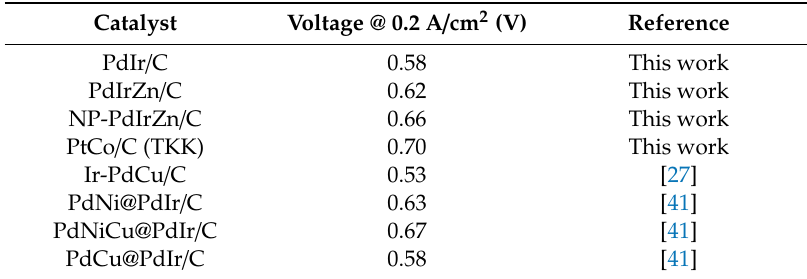
Figure 6. Single-cell performances of PdIr, PdIrZn, NP-PdIrZn, and TKK PtCo catalysts. Figure 6 . Single-cell performances of PdIr, PdIrZn, NP-PdIrZn, and TKK PtCo catalysts. Table 2. Single-cell performance of Pd-Ir-based alloy respectively, which represents the mixed activation- and Ohmic-controlled voltage of the PEMFC.